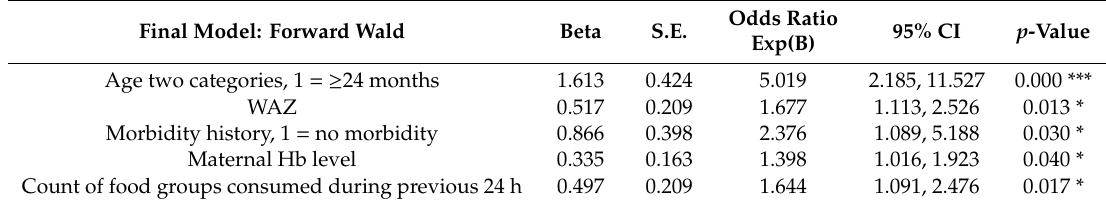
Table 6. Ratio of odds of having an Hb ≥ 10 g / dL, including 11 predictors ( n = 46 / 196, 23.5% prevalence). Final Model: Forward